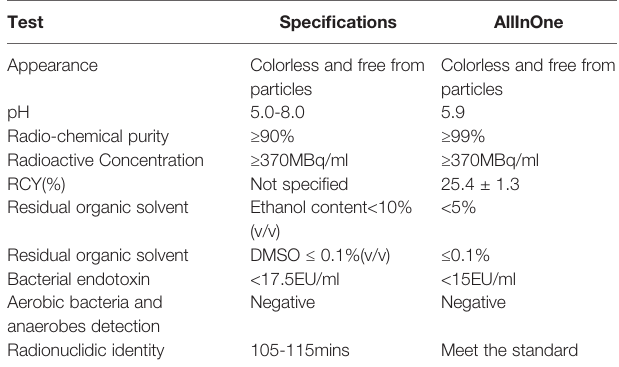
TABLE 2 | Representative results of [ 18 F]AlF-FAPT production using AllInone module.